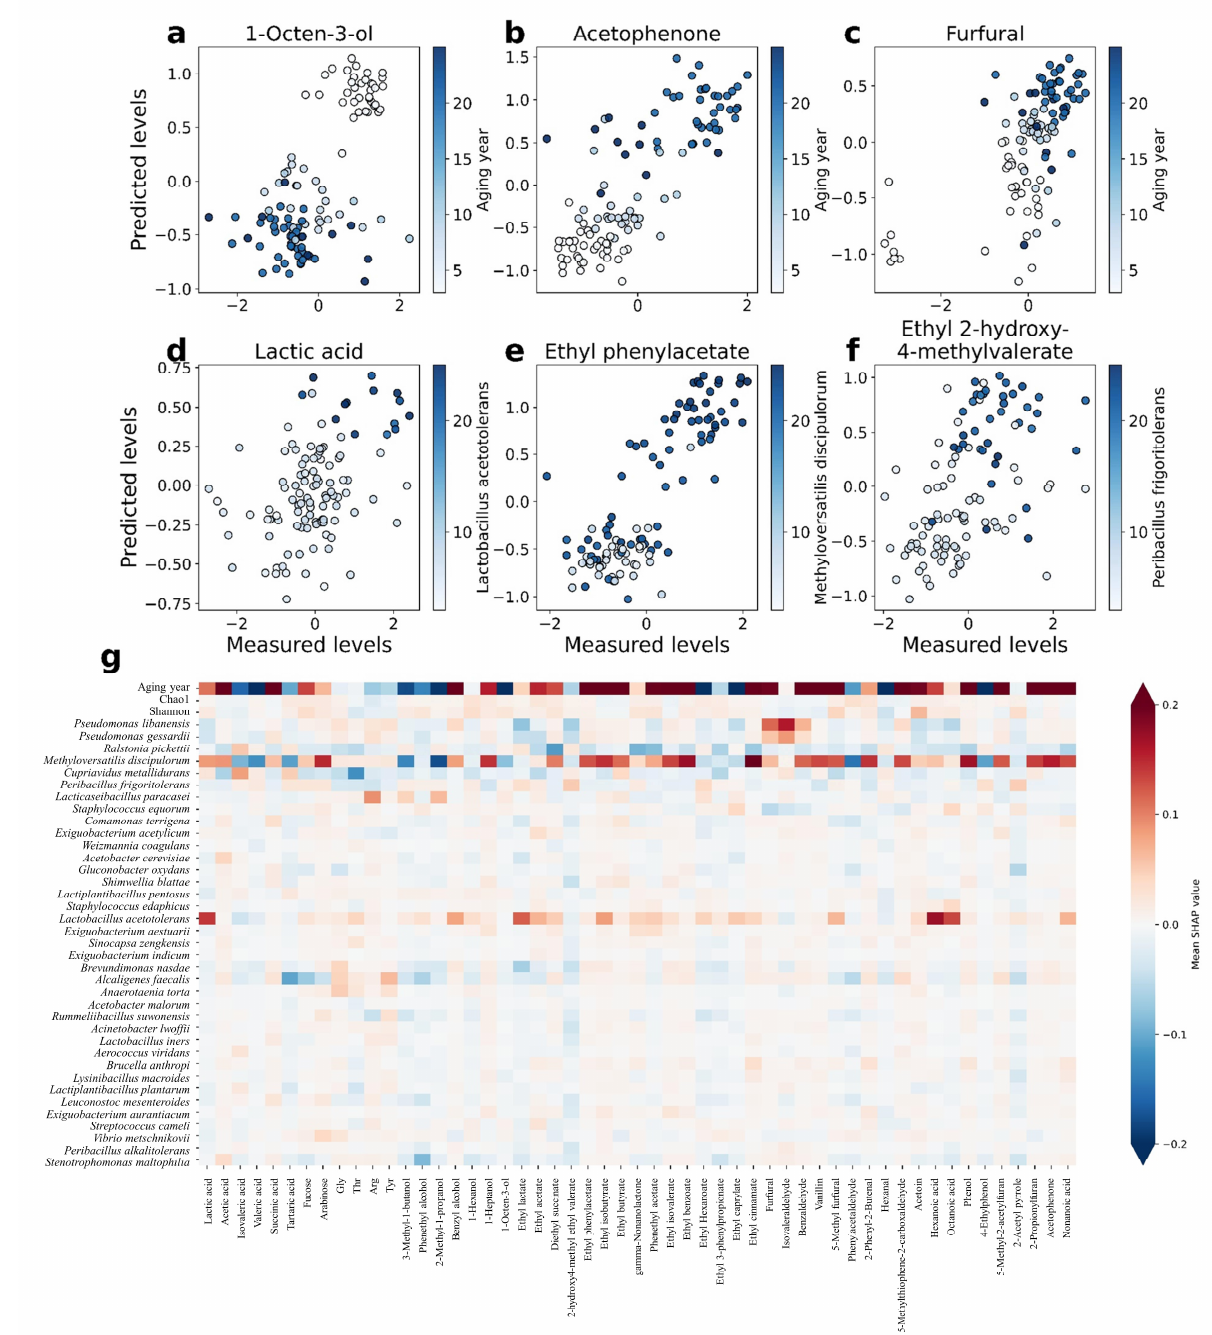
Figure 7. Specific bacterial taxa underlie the accurate prediction of aging metabolites. ( a – f ), predicted (y-axis) versus measured level of 1-octen-3-ol ( a ), acetophenone ( b ), furfural ( c ), lactic acid ( d ), ethyl phenylacetate ( e ), and ethyl 2-hydroxy-4-methylvalerate. Predictions of a–c colored by the aging year. Predictions of d–f colored by the standardized relative abundance of bacterial taxa. ( g ) Heat map shows the directional mean SHAP values of aging-related factors.